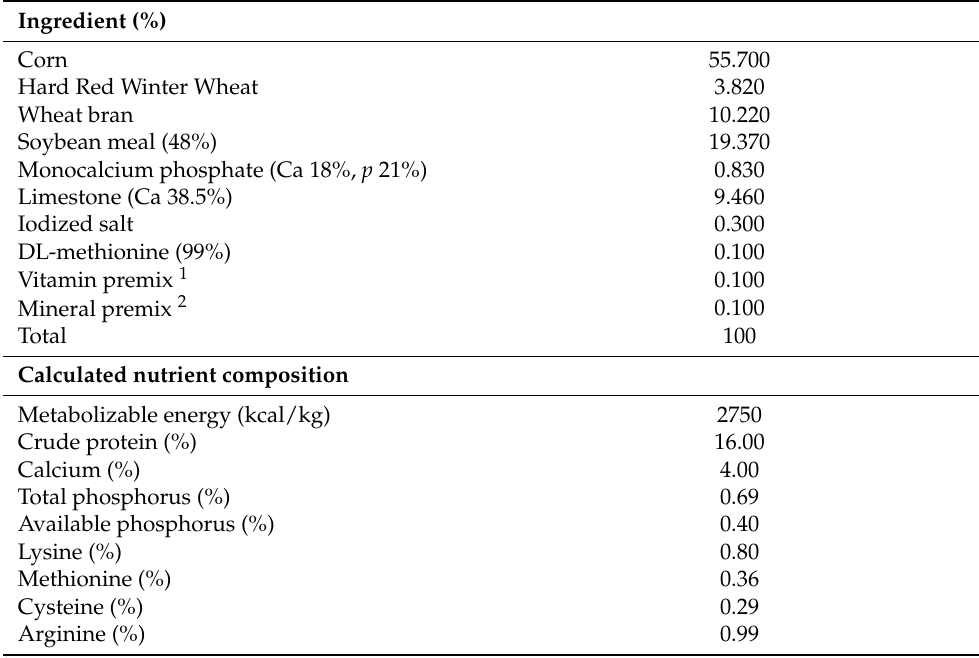
Table 1. The ingredient and nutrient composition of experimental